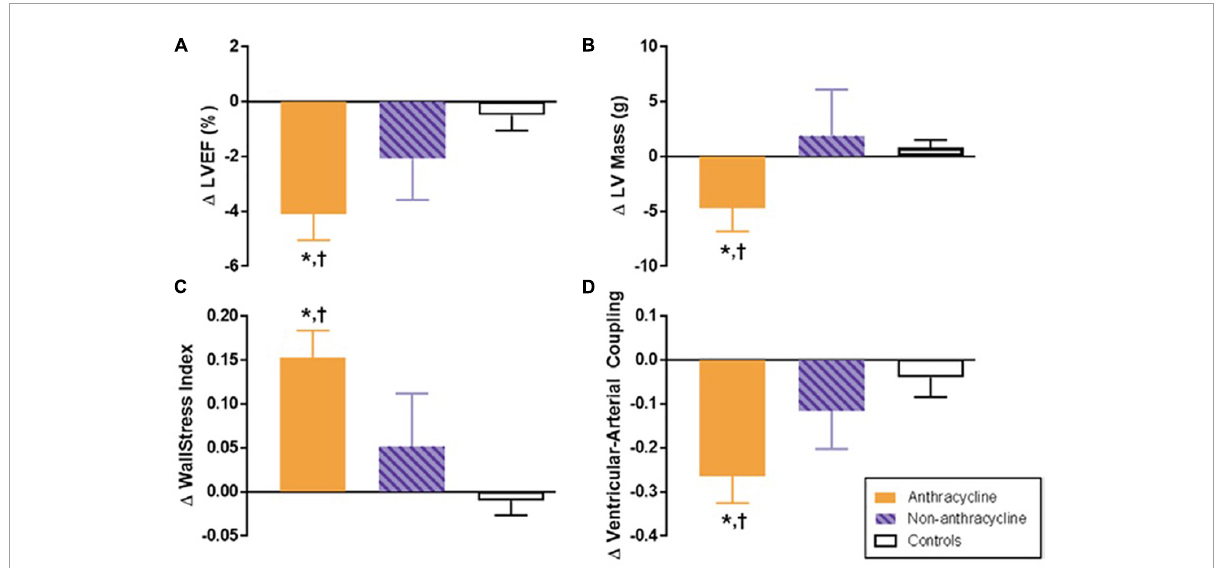
FIGURE3 Six-month change in cardiovascular magnetic resonance (CMR)-derived left ventricular (LV) remodeling measurements after anthracycline-based chemotherapy. Six-month change in CMR-derived measurements of left ventricular remodeling in adults treated with anthracycline-based chemotherapy (Anth-bC, orange), non-Anth-bC (purple) for breast cancer or hematologic malignancy and cancer-free comparators of similar age (white). Compared with cancer-free comparators, those receiving Anth-bC had a significant decrease in LV ejection fraction (LVEF; A P < 0.01) and LV myocardial mass ( B ; P = 0.03) that occurred concurrently with increased end-systolic wall stress index ( C ; P < 0.01) and reduced ventricular-arterial coupling ( D ; P < 0.01). Changes among patients with cancer who received non–Anth-bC were not statistically different than those observed in non-cancer comparators ( P > 0.15 for all). Data shown as mean ± SEM. * P < 0.05 for change from baseline. † P < 0.05 vs. change in control. From Jordan et al. (31) with permission.